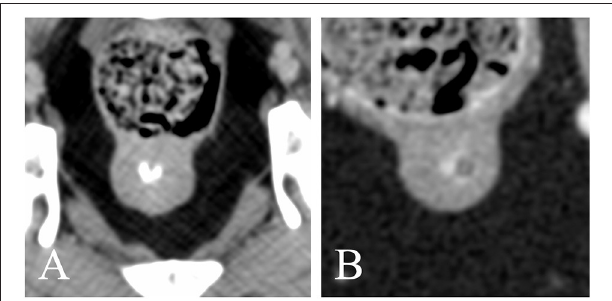
FIGURE 6 | Transverse reconstructions showing the different shape of the intra-prostatic urethral lumen (A) V-shaped; (B) O-shaped. Note the marked urethral enhancement in panel (B)